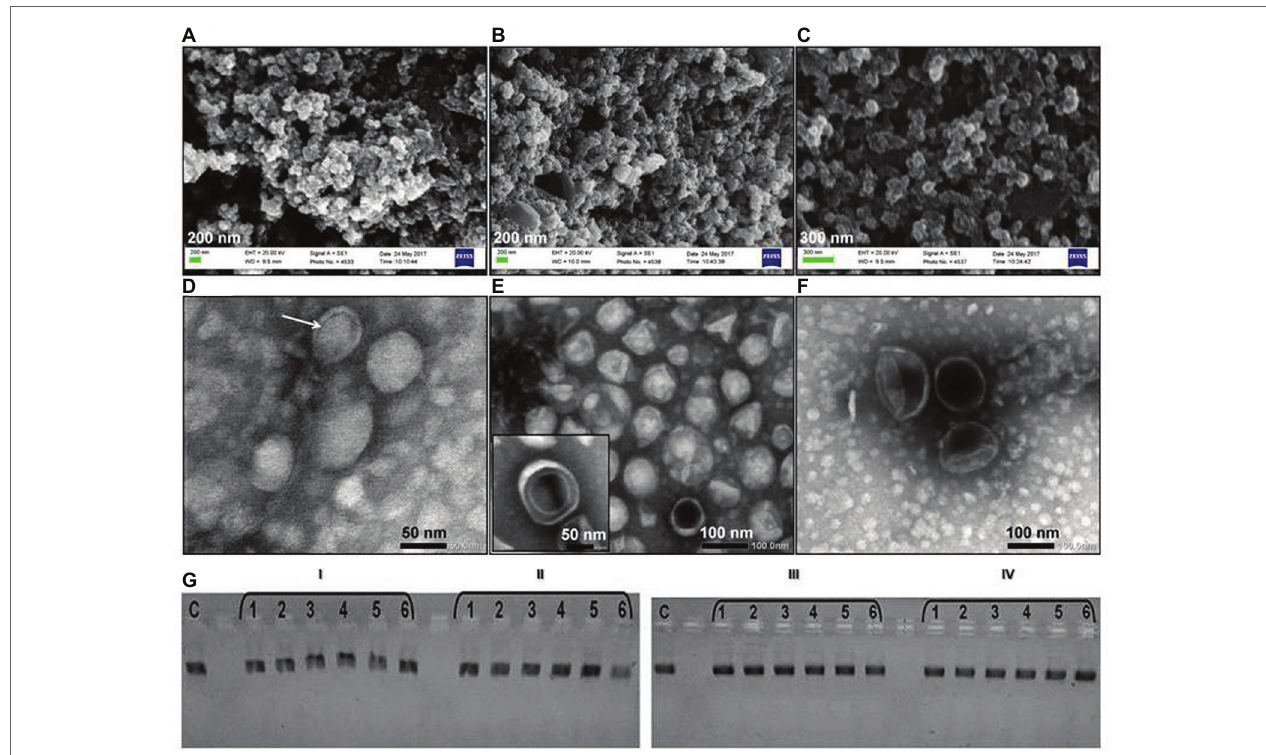
FIGURE 1 | Outer membrane vesicles (OMVs) of the key kombucha microbial community (KMC)-member Komagataeibacter intermedius recovered from the KMC samples exposed to the space/Mars-like stressors outside the International Space Station (ISS) and their interaction with a linear plasmid DNA. Scanning electron micrographs of OMVs of reference K. intermedius IMBG180 (A) ; OMVs of K. intermedius IMBG185 from KMC exposed at the top level of the carrier on the exposure platform (tKMC) (B) ; OMVs of K. intermedius IMBG183 from KMC exposed at the bottom level of the carrier on the exposure platform (bKMC) (C) ; transmission electron micrographs of OMVs with one- and double-bilayer membranes (indicated with an arrow) derived from initial reference K. intermedius IMBG180 (D) ; IMBG185, in the inset, outer-inner membrane vesicle is shown (E) ; IMBG183 (F) . Scale bars are 50–100 nm. (G) Effect of interaction of the Eco RI-linearized plasmid pTZ19R (Fermentas, Lithuania) with OMVs of K. intermedius from the initial kombucha microbial culture (KMC) (I) and KMCs exposed to Mars-like conditions, in LEO: a top level (II), a bottom level (III), and a middle level (IV). Lane C is the reference Eco RI-linearized plasmid pTZ19R. Lanes 1–6 are various concentrations of OMVs (1.25–0.25 mg ml −1